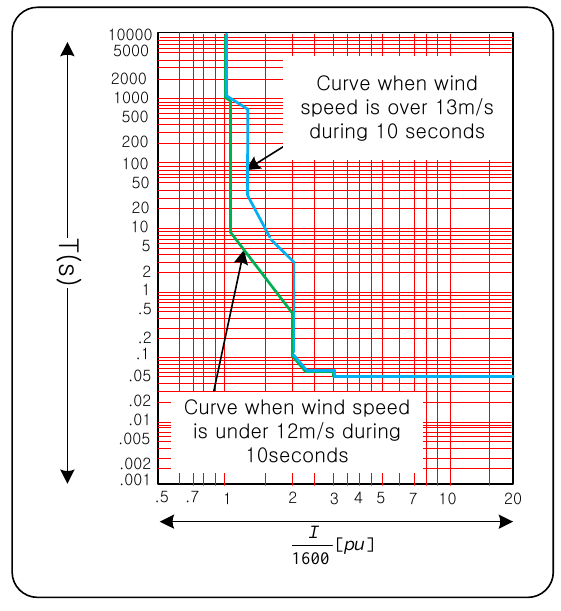
Figure 7. Final coordination of OCR.